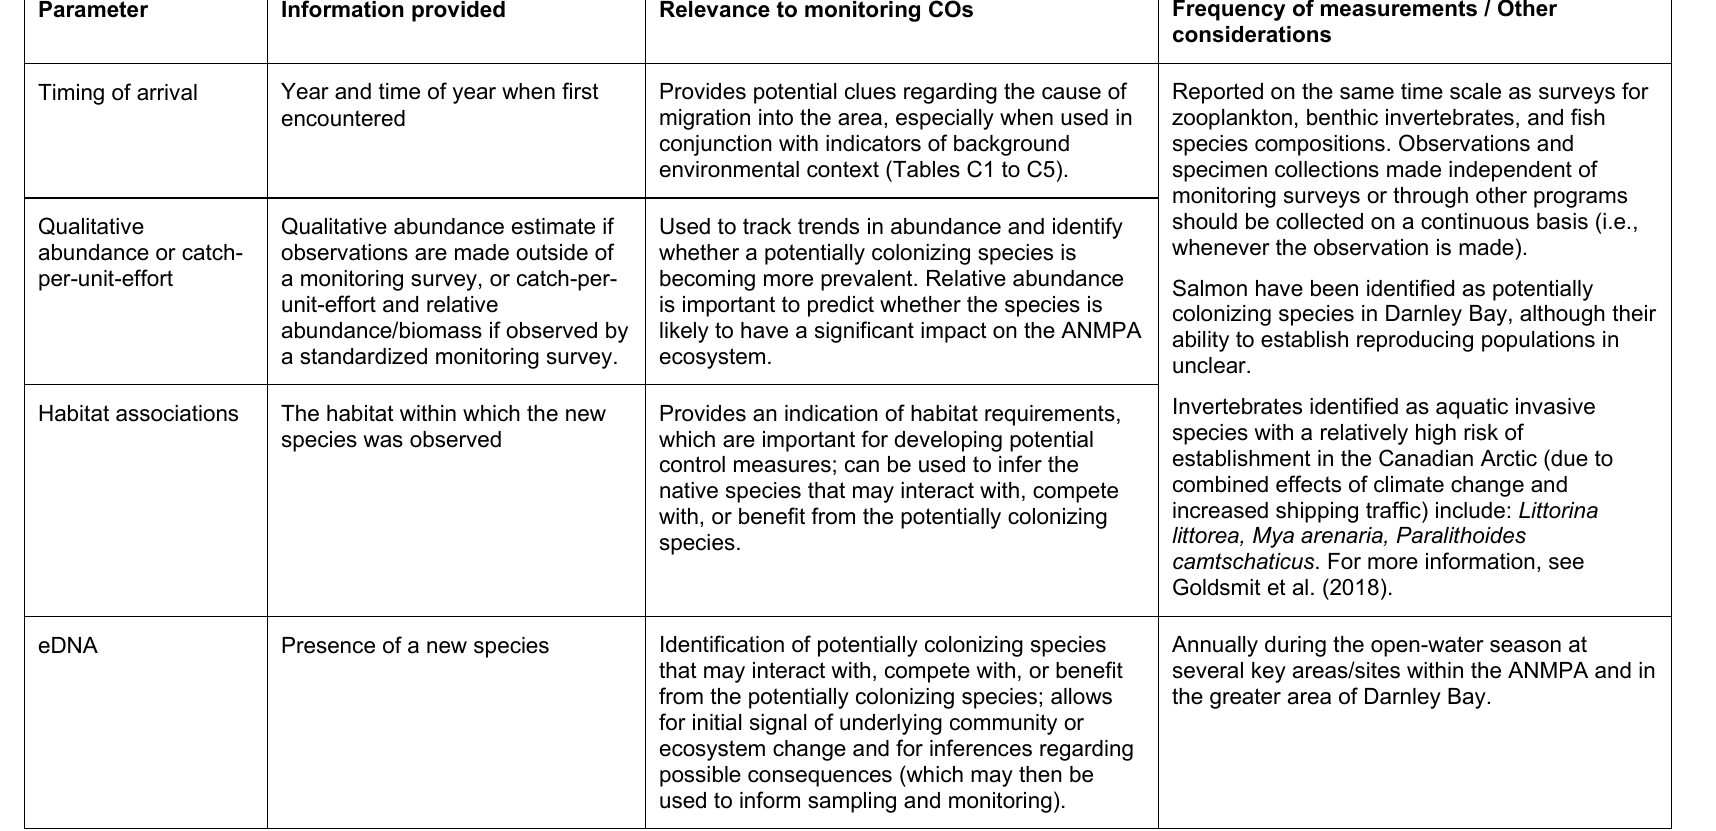
Table C6.9. Key measurement parameters for monitoring the occurrence and timing of potentially colonizing species (Section